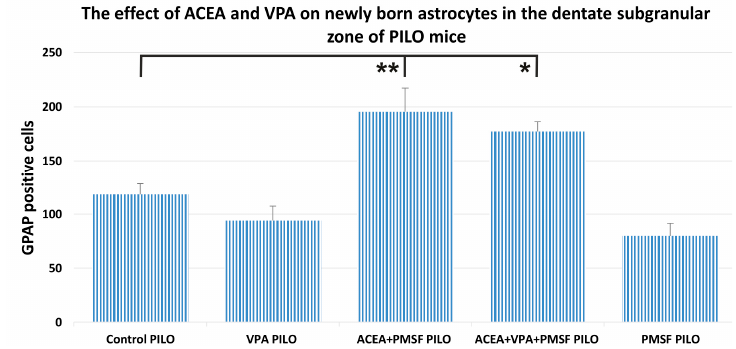
Figure 4. The effects of ACEA and VPA on newly born astrocytes in the dentate subgranular zone of PILO mice. The numbers of cells represent an estimate of the total number of positively labeled cells in the subgranular zone in both hemispheres. The results were analyzed using one-way analysis of variance (ANOVA) followed by the Dunnet’s test for multiple comparisons. Total numbers of BrdU/GFAP-positive cells slightly decreased after VPA PILO injections, whereas in ACEA + PMSF + VPA PILO-treated mice a significant increase in newly born cells was observed as compared to the PILO control group ( p < 0.05 ). The total number of BrdU/GFAP positive cells in PMSF PILO mice was not significantly different in comparison to the PILO control group ( p > 0.05 for comparisons). Each bar represents the mean for five or six mice; error bars are S.E.M. (* p < 0.05; ** p < 0.01).